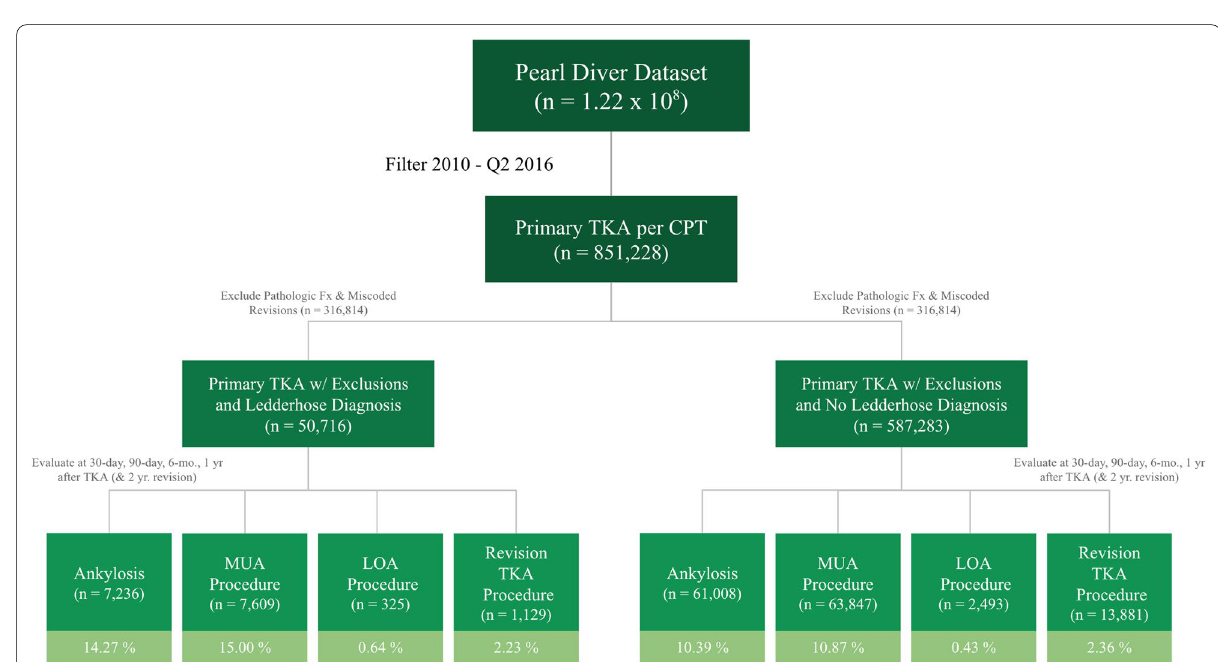
Fig. 1 Creation of primary patient cohorts with ankylosis and procedures following primary